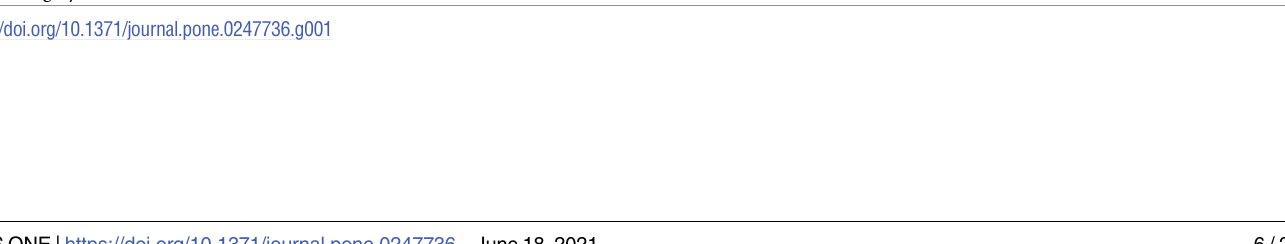
PLOS ONE | https://doi.org/10.1371/journal.pone.0247736 June 18,